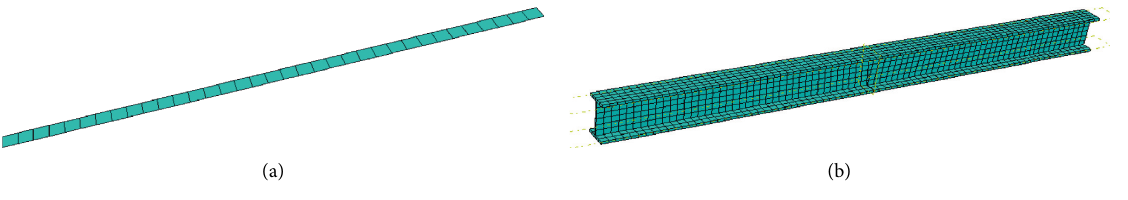
Figure 8: Model development. (a) CFRP sheet. (b) Steel